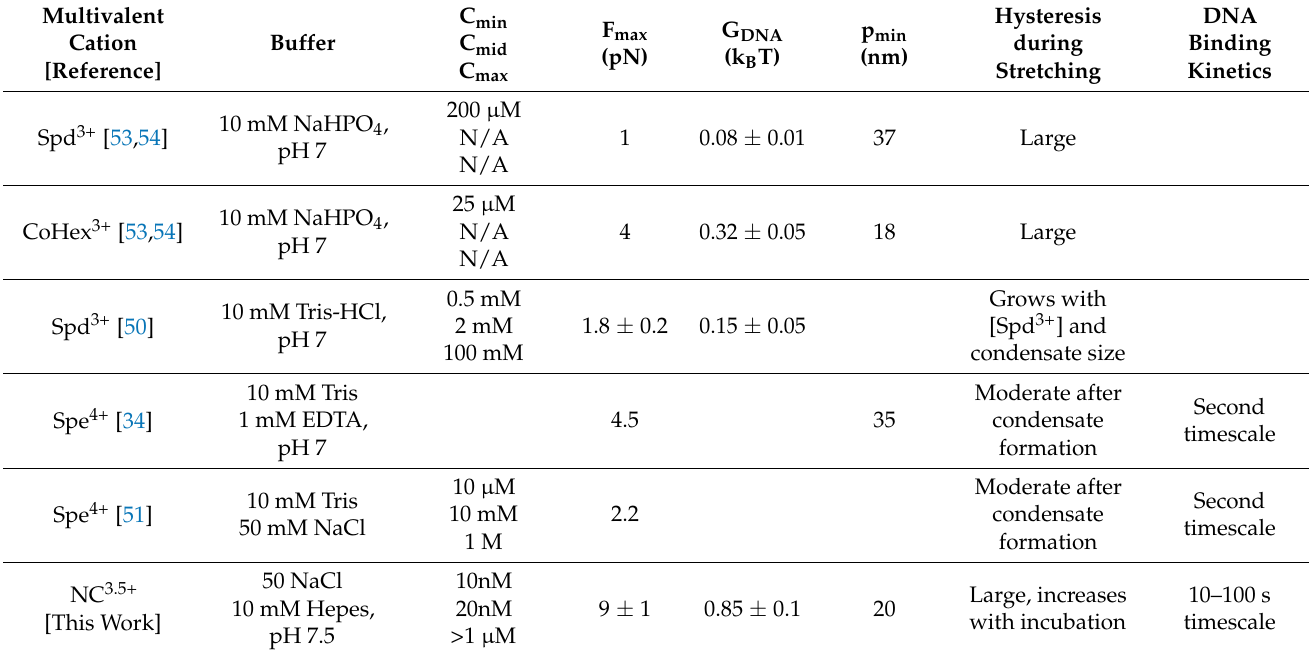
Table 1. Comparison of DNA condensation properties of NC and other multivalent cations. Summary includes buffer conditions of experiments, cation concentrations resulting in the onset, maximization, and end of DNA condensation (C min , C mid , C max ), maximum force plateau (F max ), maximum free energy associated with DNA condensation per bp (G DNA ), persistence length of DNA saturated with cation (p min ), the degree of hysteresis between stretching and release of DNA condensate, and the measured timescale of DNA